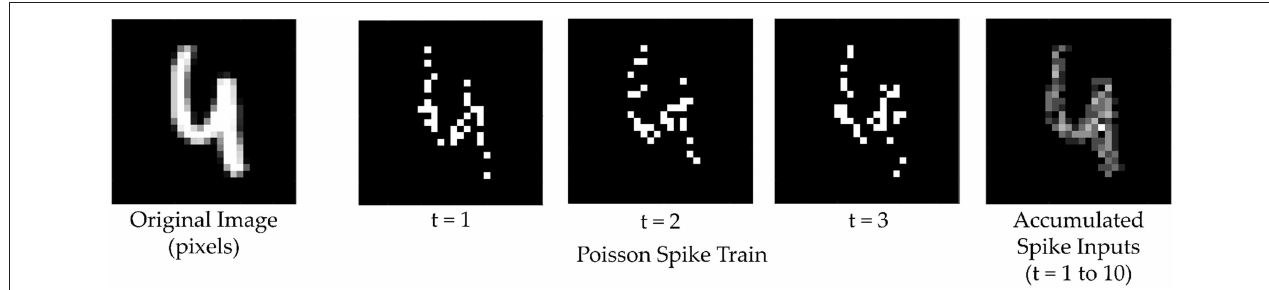
FIGURE 1 | The input image is converted into a spike map over time. At each time step neurons spike with a probability proportional to the corresponding pixel value at their location. These spike maps, when summed over several time steps, reconstruct the original input.